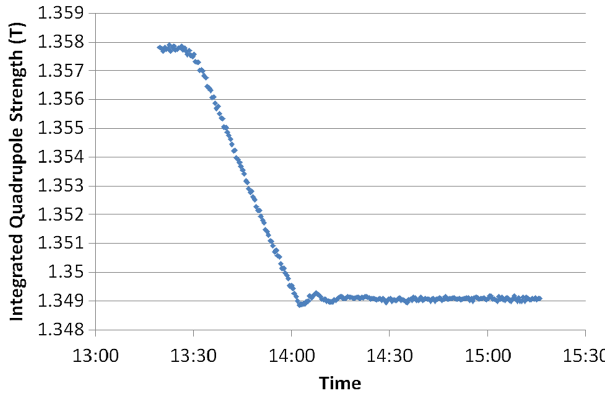
FIG. 7. Measured strength of a QD quadrupole as its temper- ature is stabilized from room temperature to 29 . 4 °C.